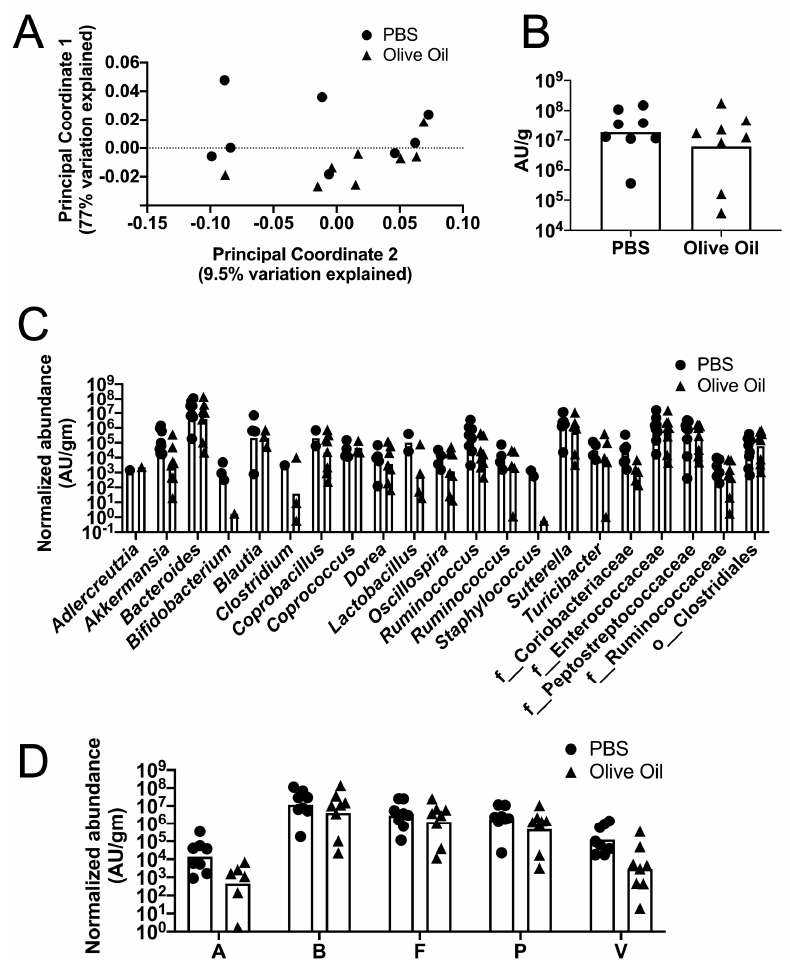
Figure 4. Analyses of the cecal bacterial communities in the PBS or olive oil-fed mice infected with C. difficile. Mice were treated as described in Figure 2A. On day 2 post-inoculation with C. difficile spores, the mice were sacrificed and their ceca were removed. Bacterial composition was analyzed as described in the Materials and Methods with QIIME 2. ( A ) Weighted UniFrac distances were used to perform a Principal coordinate analysis. ( B ) Total levels of bacteria per cecal tip sample were measured by qPCR using eubacterial primers and normalized to milligrams of cecum sample used for DNA extraction. Bar indicates geometric mean. ( C ) Normalized abundance per mg of cecum sample for the bacterial genera in the cecal microbiota ( n = 8 mice per group). ( D ) Phyla are abbreviated as follows P = Proteobacteria; V = Verrucomicrobia; A = Actinobacteria; F = Firmicutes; B = Bacteroidetes. The black circles indicate the PBS-treated, C. difficile -challenged mice. The black triangles indicate the olive oil-fed, C. difficile -challenged mice.